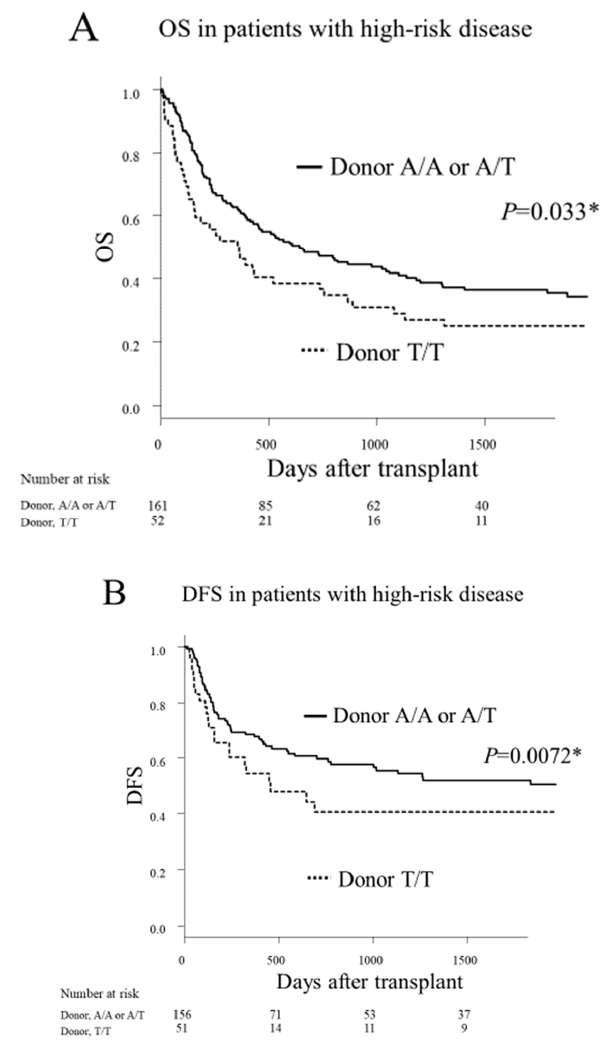
Figure 1. The Kaplan–Meier analysis of the overall survival (OS) rates ( A ) and the disease-free survival (DFS) rates ( B ) after transplantation, according to the donor HO-1 genotype in patients with high-risk disease. Solid lines represent the donor A/A or A/T genotype. Dashed lines represent the donor T/T genotype. An asterisk (*) denotes statistical significance ( p < 0.05).